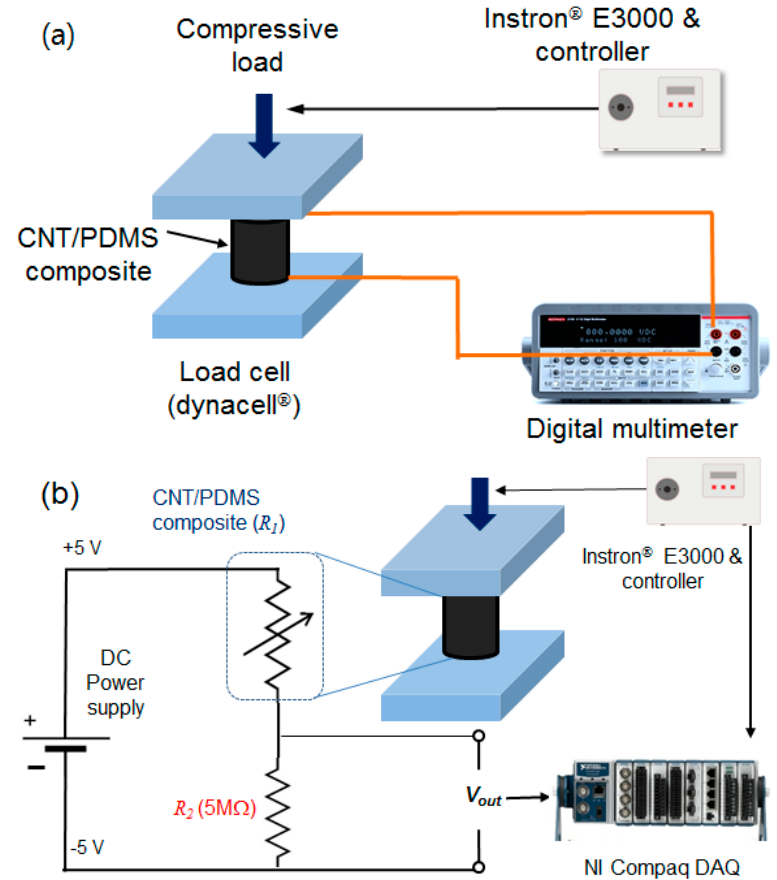
Figure 5. Experimental setup for measuring the ( a ) electrical resistance and ( b ) and voltage output using a voltage divider circuit.